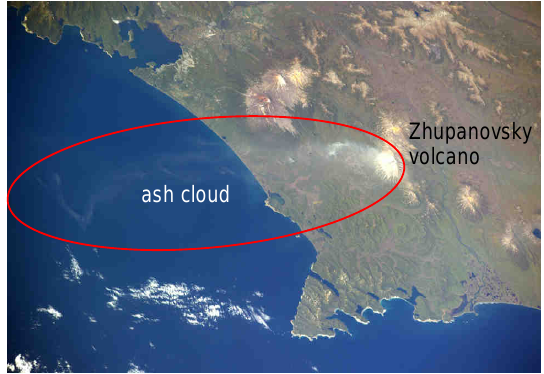
Figure 5. A photo (number ISS041e000162) of Zhupanovsky volcano and it ash cloud on Septemebr 10 2014 at 23:11 UTC; it is a courtesy of the Earth Science and Remote Sensing Unit, NASA Johnson Space Center.